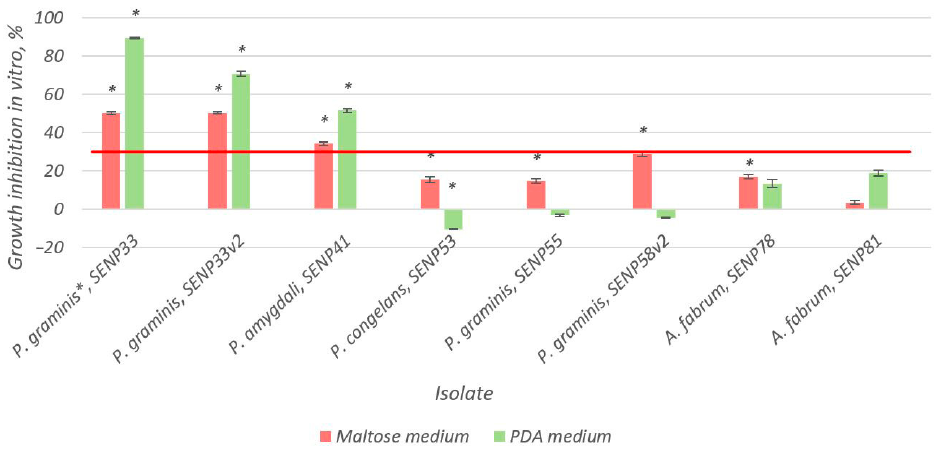
Figure 1. Inhibition of the growth of Monilinia fructigena in vitro on two different media (maltose- based and Potato Dextrose Agar (PDA) with a standard composition) as percentages ± SE. The red line denotes 30% radial growth inhibition, which is considered to be the minimum requirement for a biocontrol agent, as per Ulrich et al. [56]. The test was performed using the Kruskal–Wallis one- way analysis of variance on ranks, followed by pairwise comparisons with Dunn’s test. Significant divergences from the control are marked as * ( p ≤